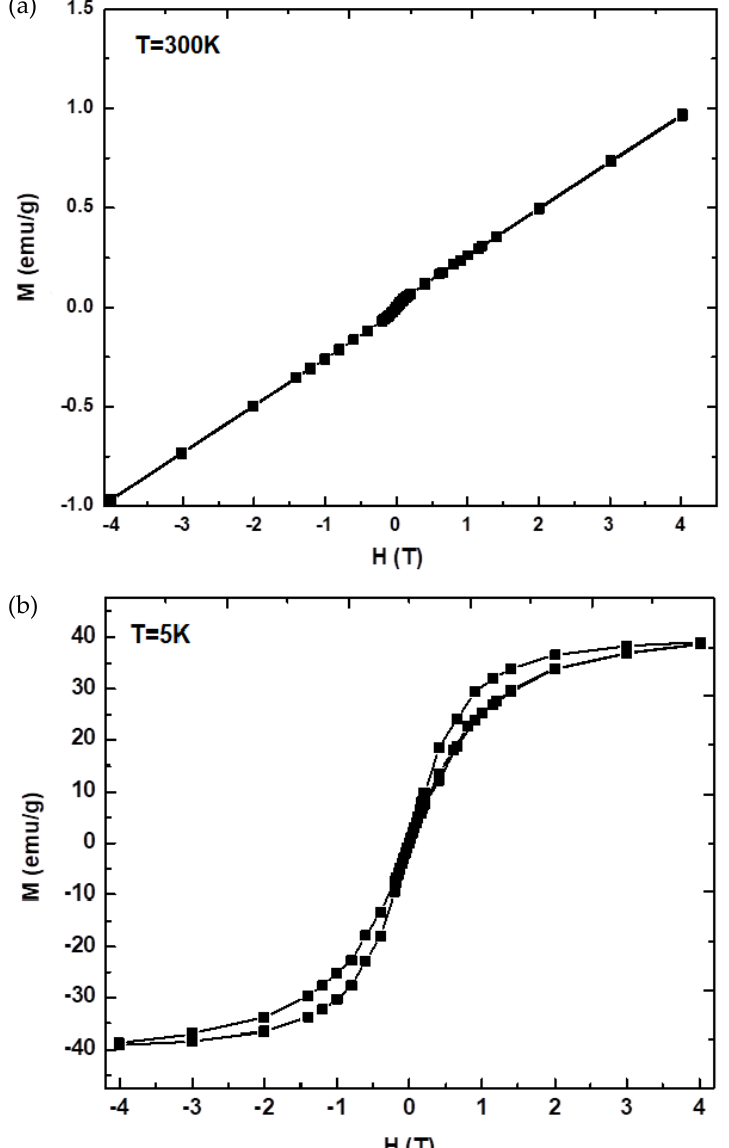
Figure 6. The magnetization hysteresis loops recorded at room temperature ( a ) and 5K ( b ) on